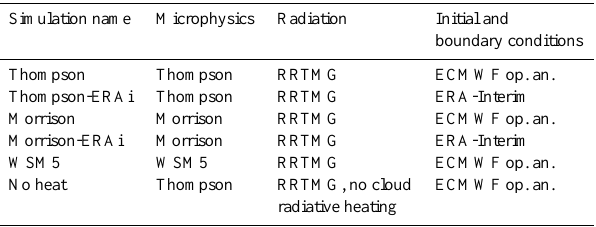
Table 1. List of parameterizations and simulations used in this pa- per.